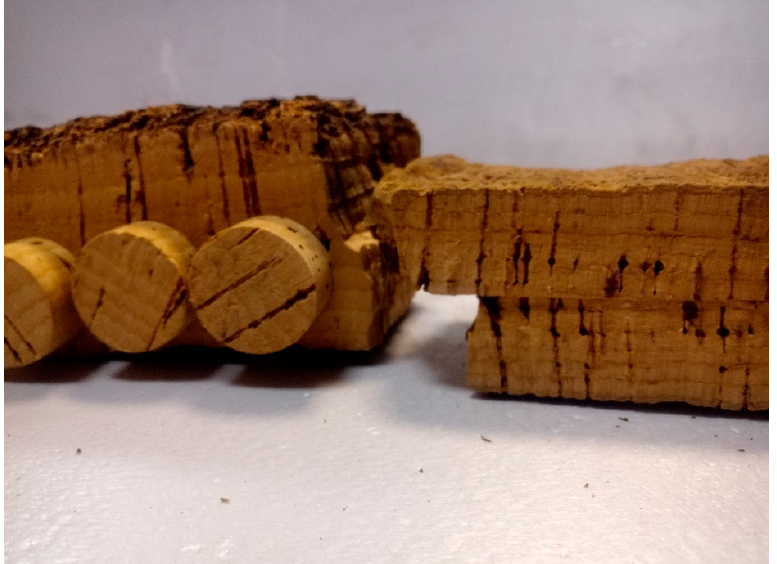
Figure 1. Perforated cork sheet to obtain one-piece stoppers on the left and 2 thin cork sheets glued together to achieve the same useful thickness and manufacture two-piece stoppers on the right.